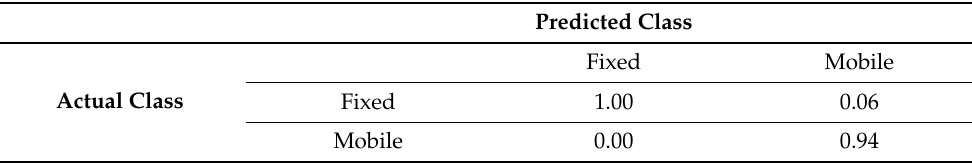
Table 6. Confusion matrix normalized with respect to the predicted